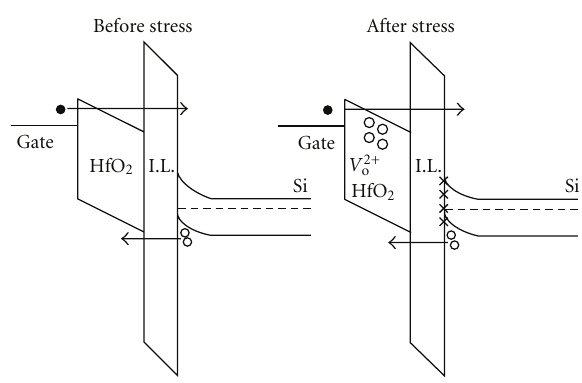
Figure 10: Band diagram of I G - V G curve in strong inversion